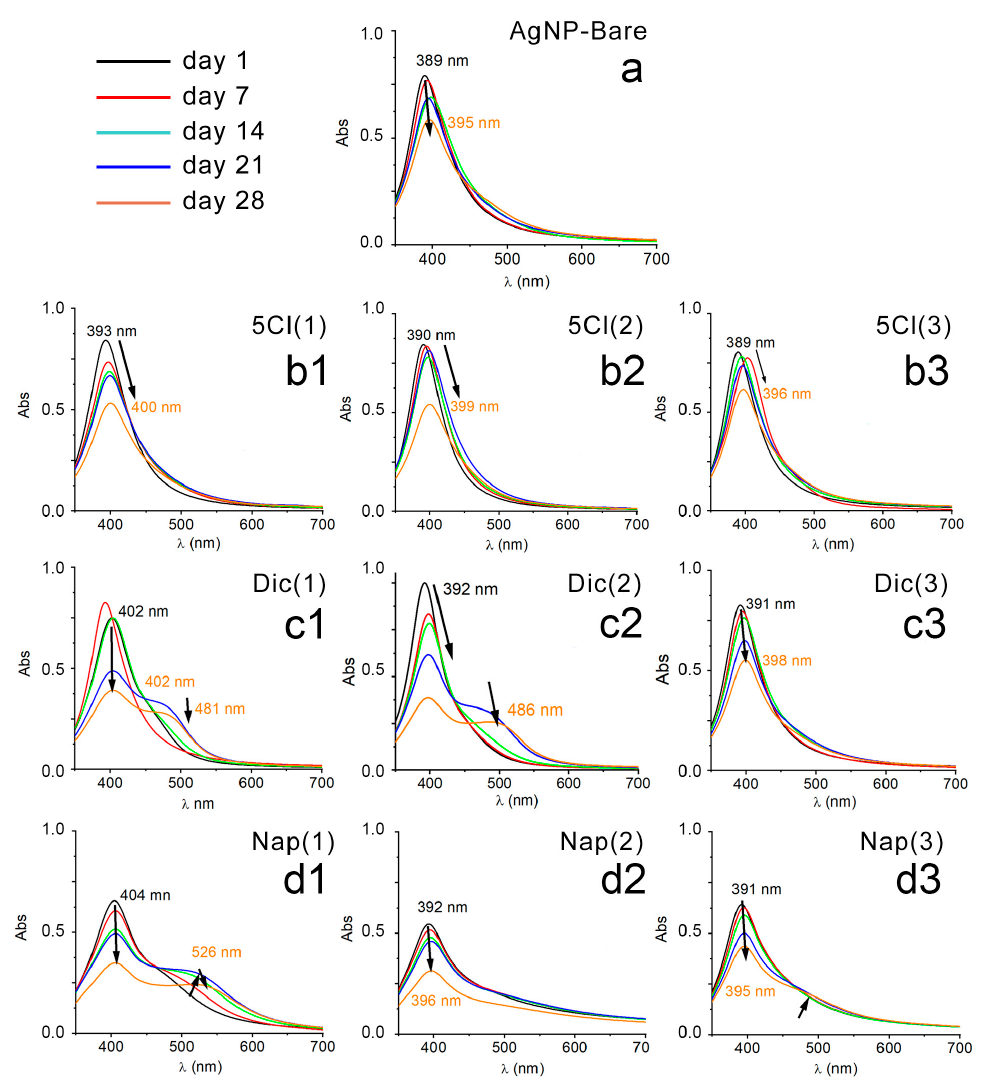
Figure 1. UV–Vis spectrum: ( a ) AgNP-Bare, ( b1 ) AgNP-5-Cl (1), ( b2 ) AgNP-5-Cl (2), ( b3 ) AgNP-5-Cl (3), ( c1 ) AgNP-Dic (1), ( c2 ) AgNP-Dic (2), ( c3 ) AgNP-Dic (3), ( d1 ) AgNP-Nap (1), ( d2 ) AgNP-Nap (2), ( d3 ) AgNP-Nap (3), every 7 days and up to 28 days.